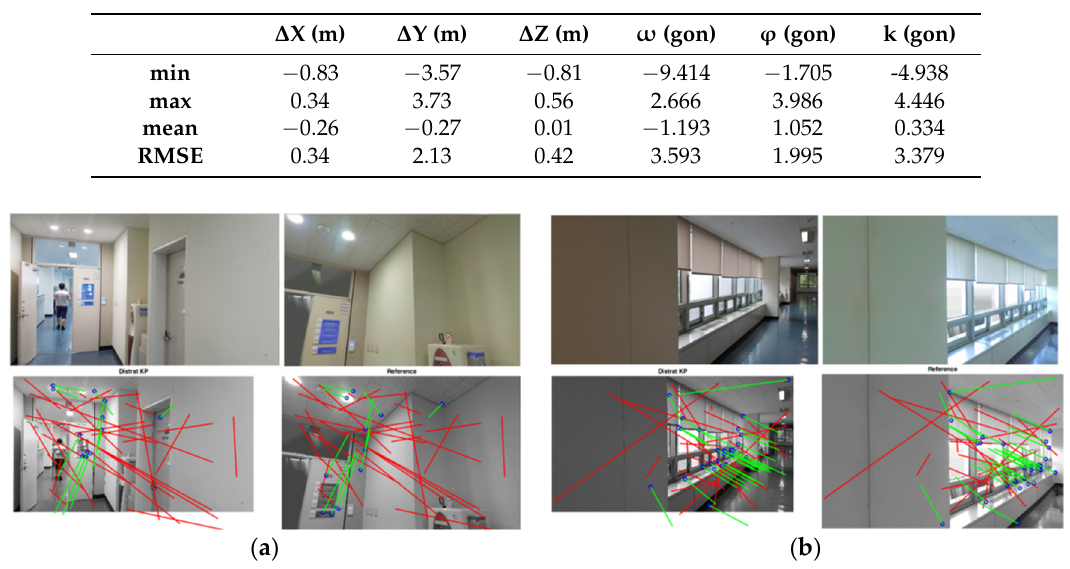
Table 6. Accuracy in ETRI building with Samsung Galaxy S7 Edge.